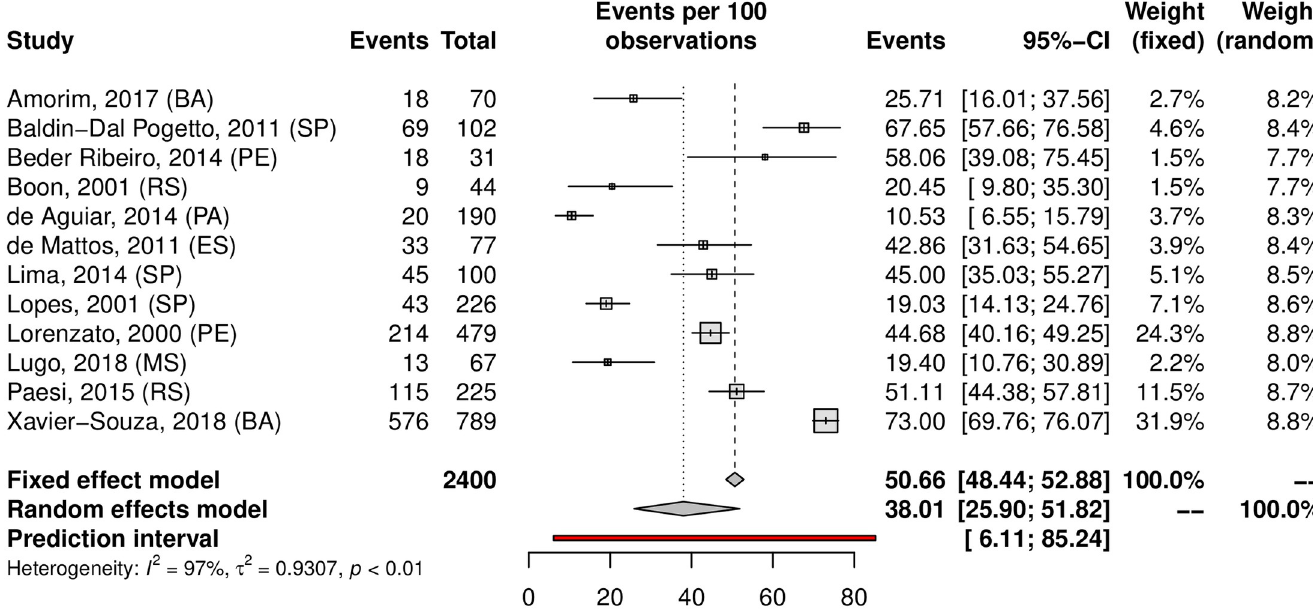
Fig 6. Prevalence of cervical HPV infection in high-risk populations. Forest plot of a metanalysis of studies reporting prevalence of cervical infection by HPV in high-risk populations in Brazil.